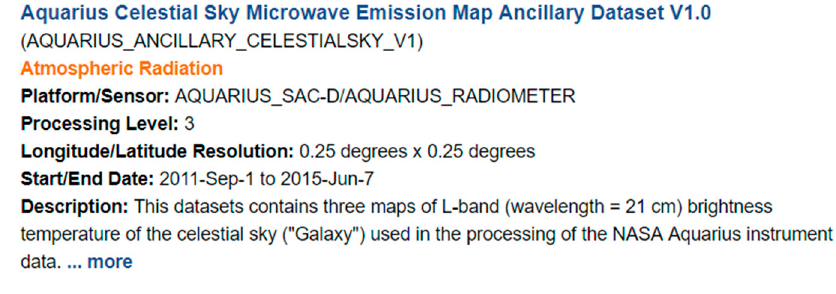
Figure 1. A sample PO.DAAC metadata.